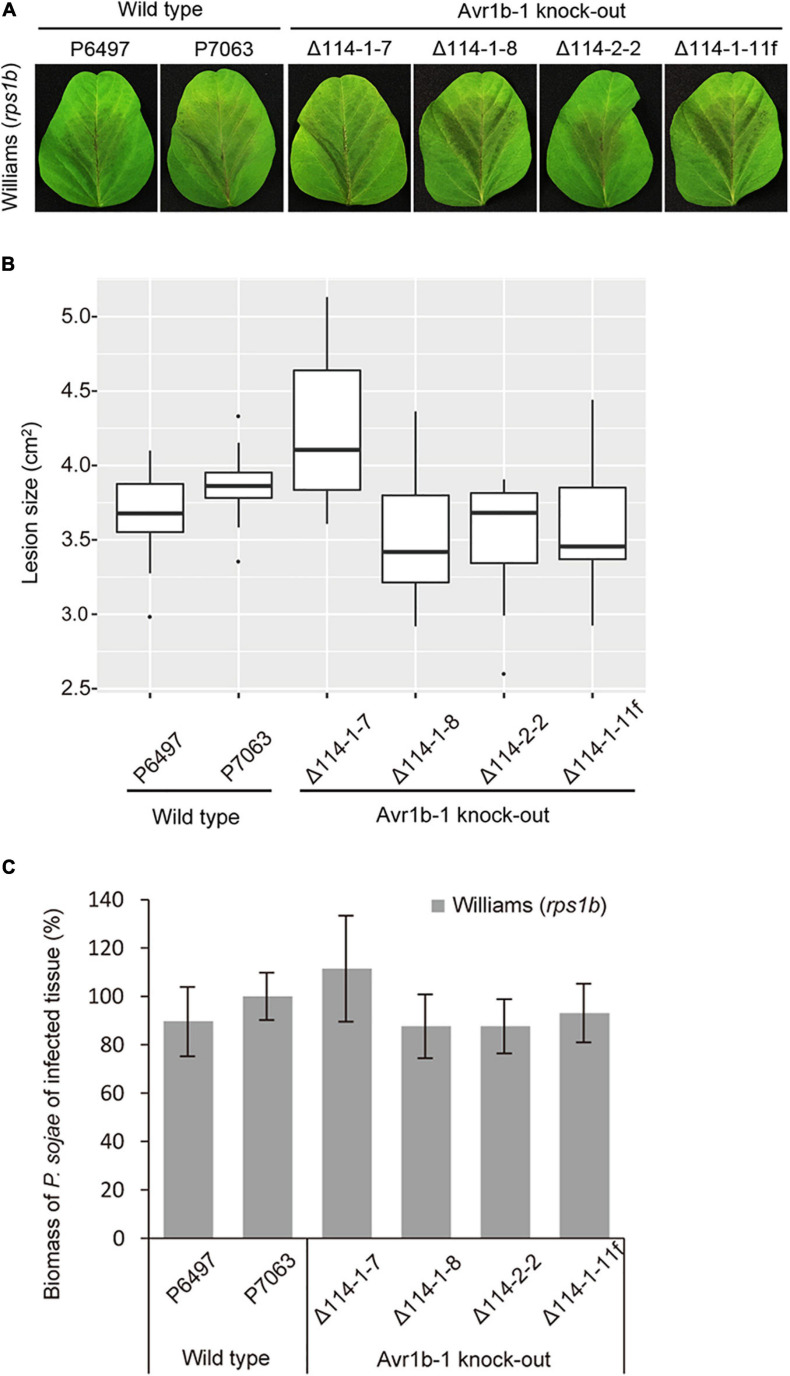
Virulence phenotypes of Avr1b-1 knock-out transformants on Williams soybean leaves. (A)
Avr1b-1-silenced isolate P6497; Avr1b-1-expressing isolate P7063; three homozygous Avr1b-1 deletion transformants Δ114-1-7, Δ114-1-8, and Δ114-2-2; plus non-HDR transformant Δ114-1-11f were inoculated onto unifoliate leaves of Williams (rps1b). Pictures were taken 3 days after inoculation. (B) Average lesion sizes determined from at least 10 inoculated unifoliate leaves in each of three independent experiments. The relative lesion sizes were measured by ImageJ software. Error bars represent the mean ± standard deviation. P-values were determined by the Wilcoxon rank sum test. (C) Virulence phenotypes of Avr1b-1 knock-out transformants measured by real-time PCR-based quantification of P. sojae genomic DNA in infected tissue. Error bars represent standard deviation of three technical replicates. This experiment was replicated three times. Error bars represent the mean ± standard deviation.